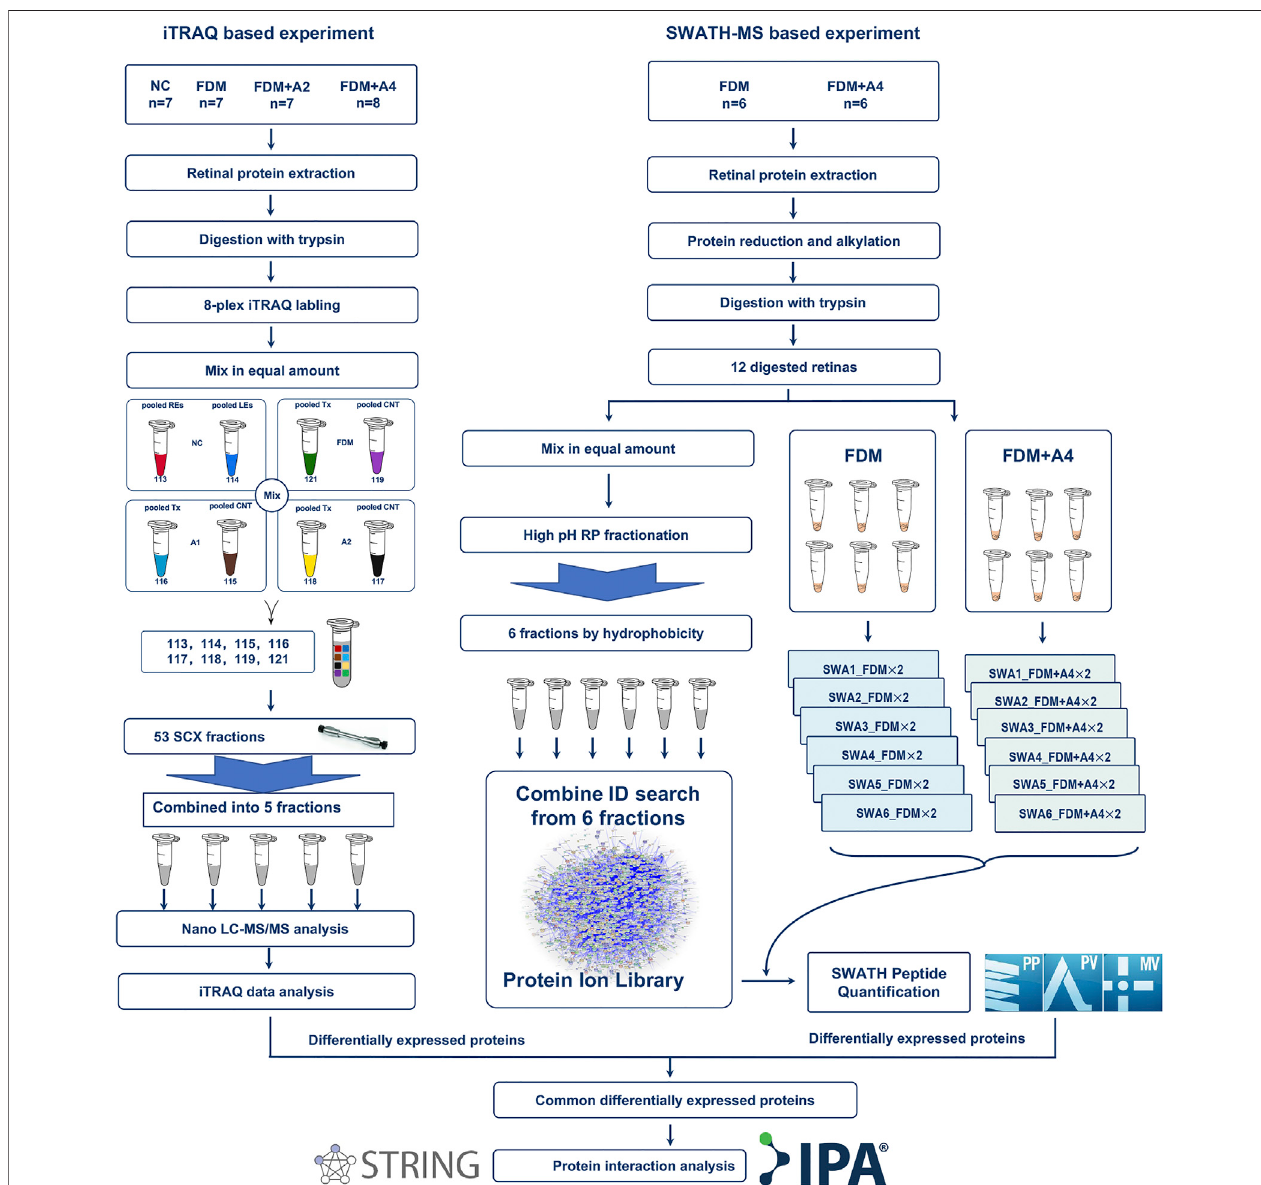
FIGURE 3 | Schematic work fl ow of quantitative proteomics using iTRAQ-MS and SWTAH-MS proteomics to study effects on protein regulation of atropine treatment on myopic (FDM) eyes. Overall, six individual retinal samples from each time point were equally pooled to form representative retinal lysates of speci fi c groups using an iTRAQ based proteomic approach. Another new batch of six individual retinas was selected in the validated experiment using a SWATH based proteomic approach. The 2 μ g digested protein from each sample was used as two technical replicates under SWATH-MS. Protein identi fi cation and quanti fi cation were performed using ProteinPilot, PeakView, and MarkerView software, followed by online bioinformatics analysis.